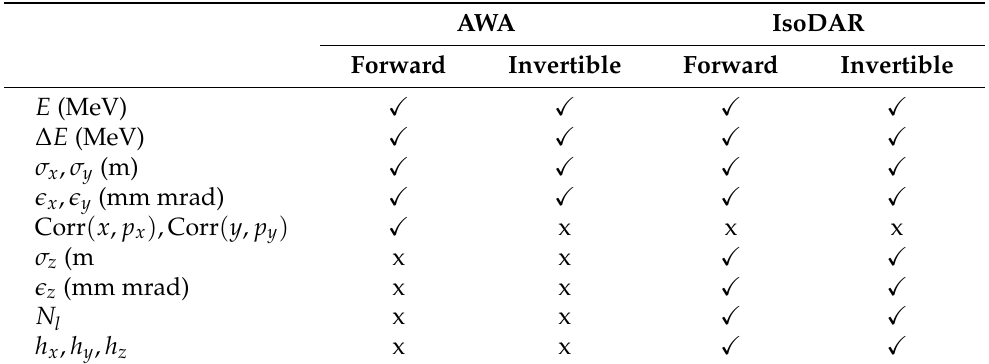
Table A2. Quantities predicted by the various models. Checkmarks (cid:88) mean that the model predicts the quantity, while crosses x mean that the quantity is not predicted by the model.